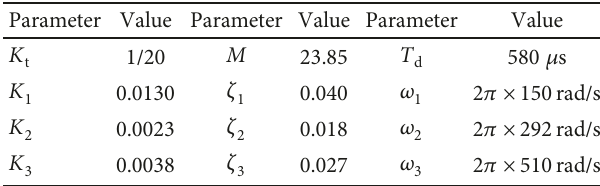
Table 1: Parameters in the wafer stage